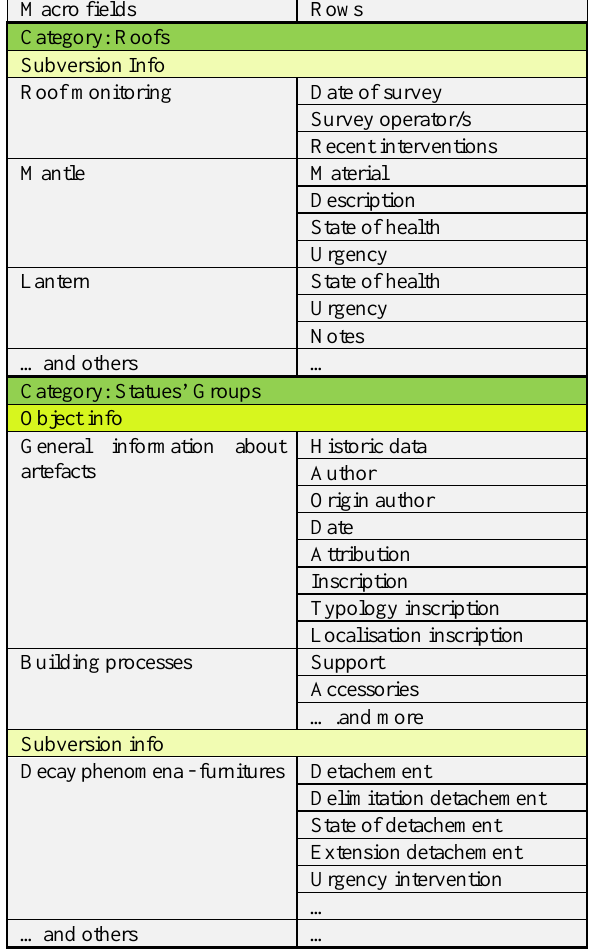
Table 2. Example of some macro-fields and their relative rows inside the info of the roofs and statues’ groups categories. E.g. for the roof category, under the subversion info, we find several macro-fields as roof monitoring, mantle, lantern and others. Under each macro-field there are the specific rows about